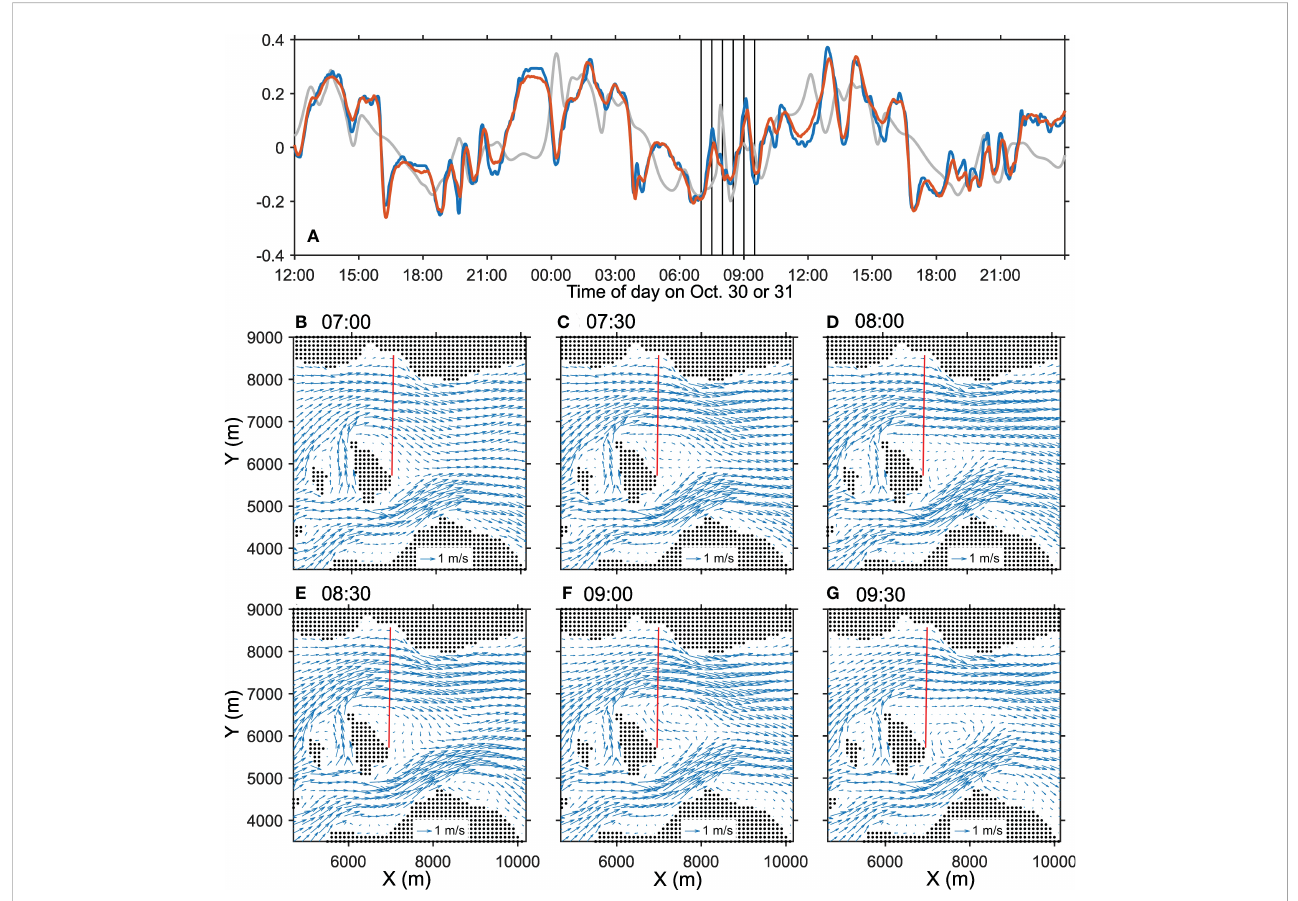
FIGURE 8 (A) Time series of path-averaged current between the S1 and S2 stations. The blue, red, and gray lines indicate the reciprocal acoustic transmission results, data assimilation results (case 3 with 98 members), and the model predictions, respectively. The positive value of the path-averaged currents corresponds to the fl ow toward the S1 station. Panels (B-G) show the snapshots of velocity fi elds at times shown as the vertical bars in (A) . The red line in panels (B-G) is the path connecting the S1 and S2